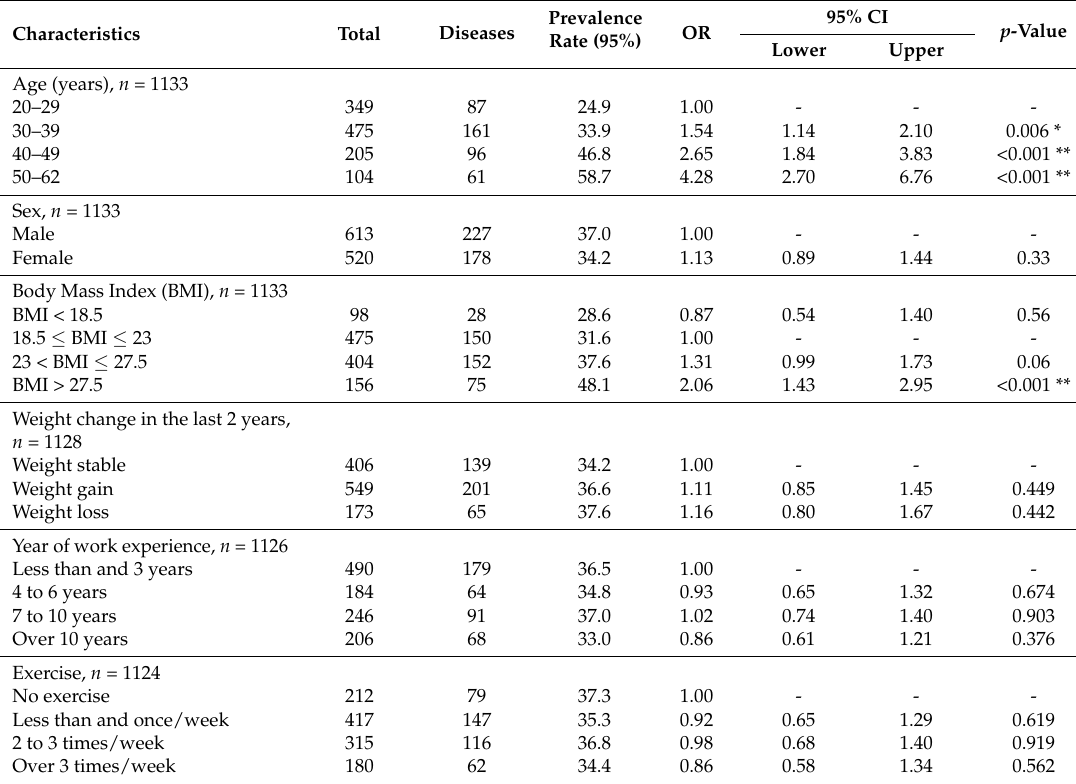
Table 1. Association between personal factors and disease prevalence (specifically CVDs, DM, CRDs, CAs, HT, and hyperlipidemia) among 1133 workers in